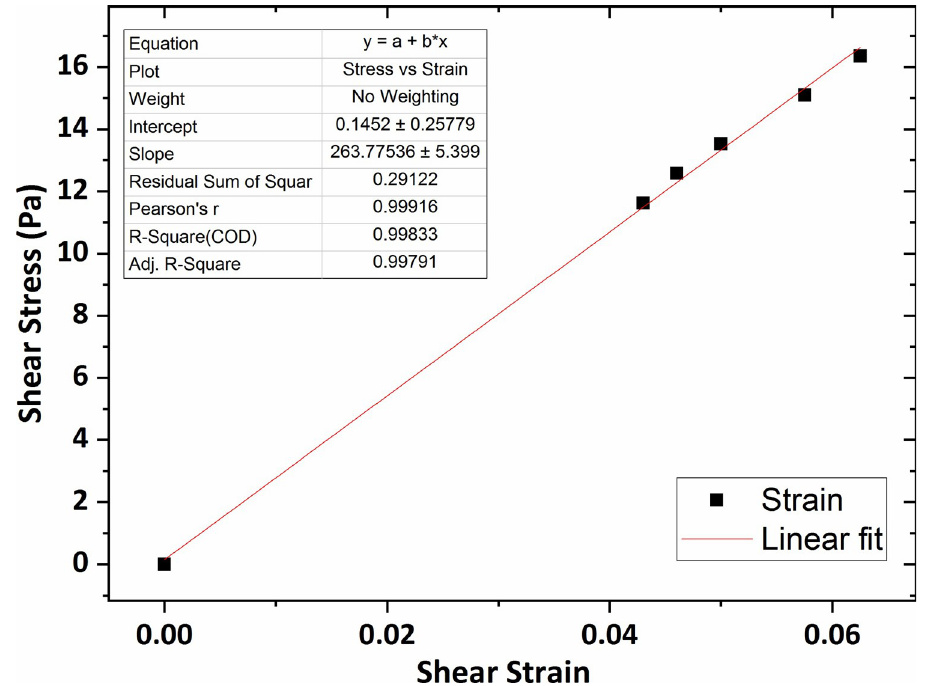
Fig 7. The graph of shear stress versus shear strain for the agarose gel of 0.2 wt % percent concentration.